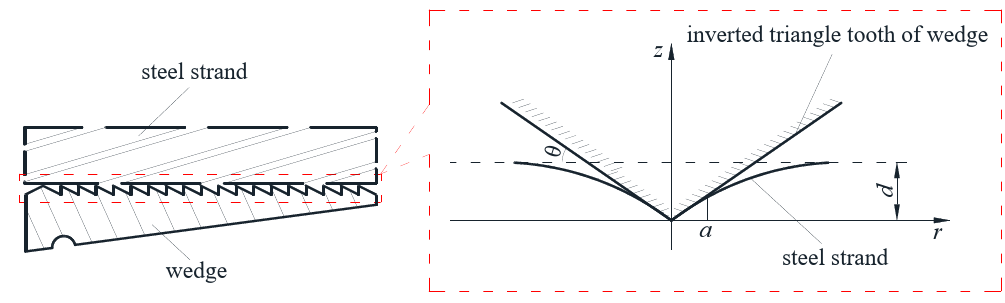
Figure 4. Contact area between steel strand and inverted triangle teeth in wedges.